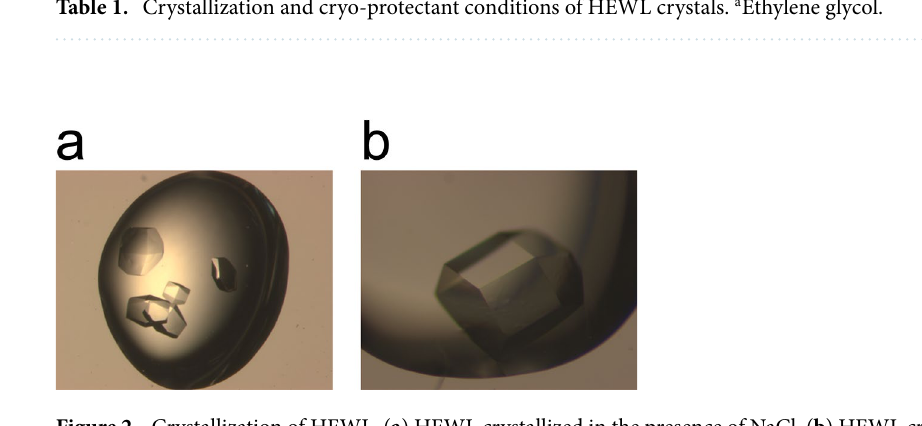
Figure 2. Crystallization of HEWL. ( a ) HEWL crystallized in the presence of NaCl. ( b ) HEWL crystallized in the presence of CsCl.